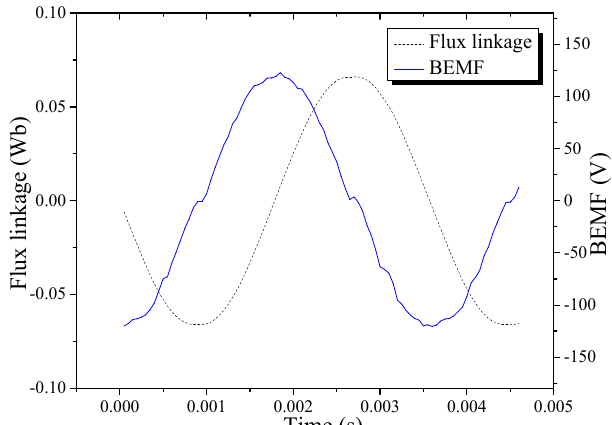
Figure 9. The flux-linkage and BEMF at